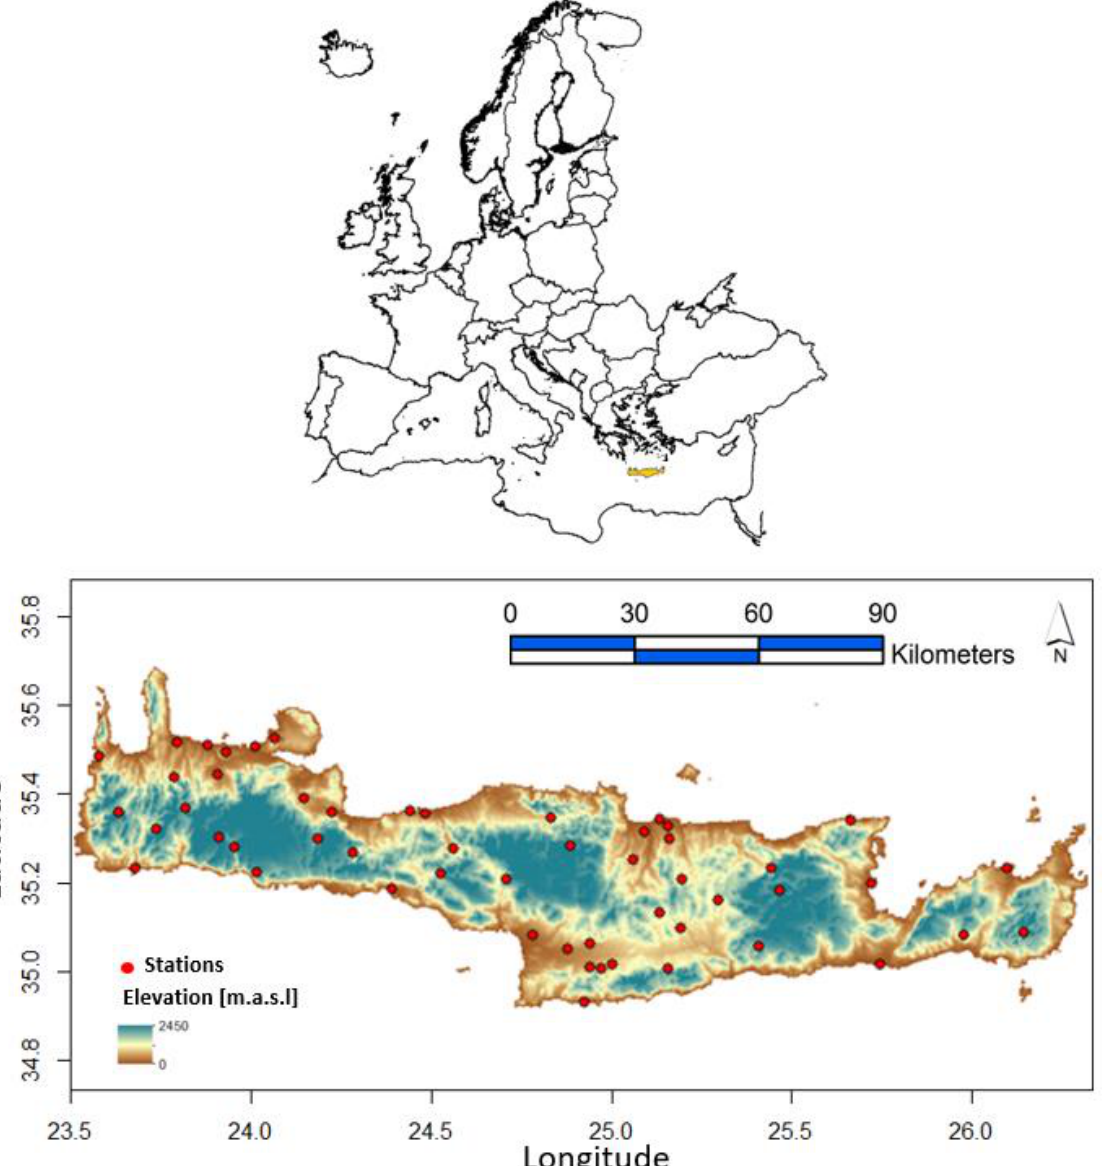
Figure 1. Digital elevation map of Crete providing the locations of the 53 meteorological stations.